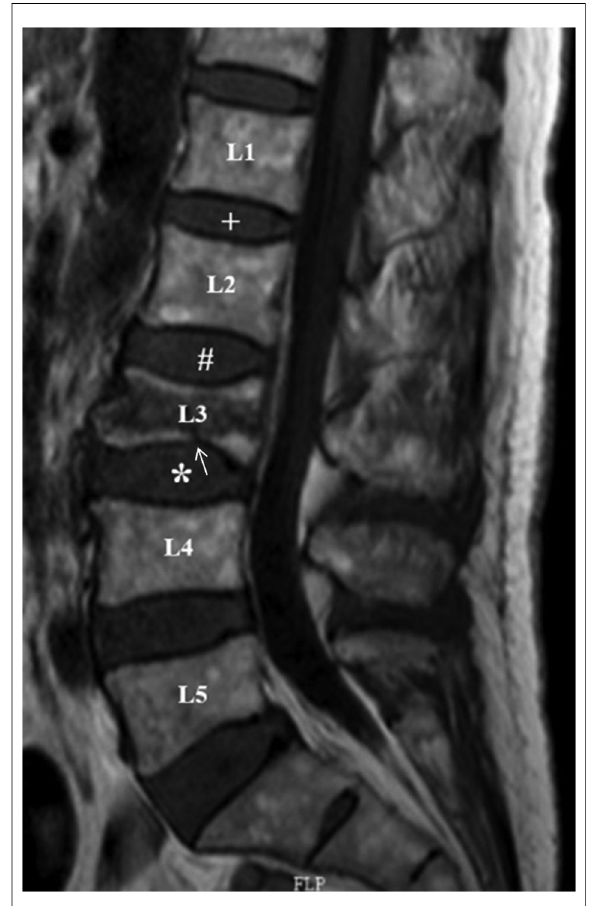
FIGURE 1 De fi nition of cranial, caudal and control discs. In the mid-sagittal view of MRI T1WI, L3 is the fractured vertebral body. L2/3 disc (#) and L3/4 disc (*) were de fi ned as the cranial and caudal adjacent discs, respectively, and L1/2 disc (+) was de fi ned as the internal control disc. The white arrow indicates caudal endplate injury of